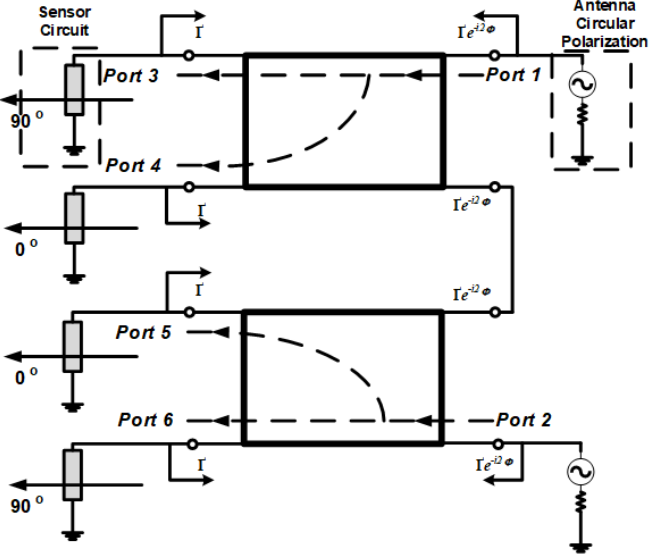
Figure 6. Wave propagation on the 2 × 4 Direction-Finding Hybrid Coupler network.